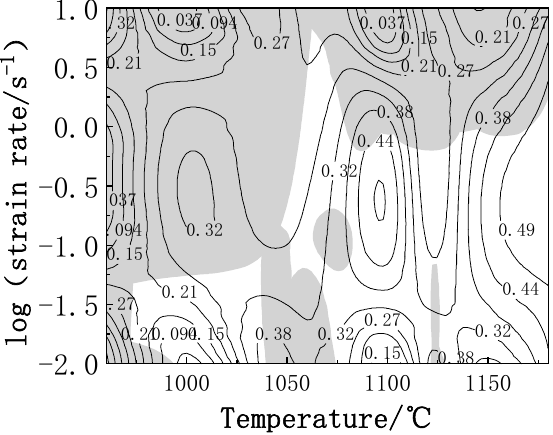
Figure 7. The new combined processing maps of HY282 alloy at the strain from 0.2 to 0.7.